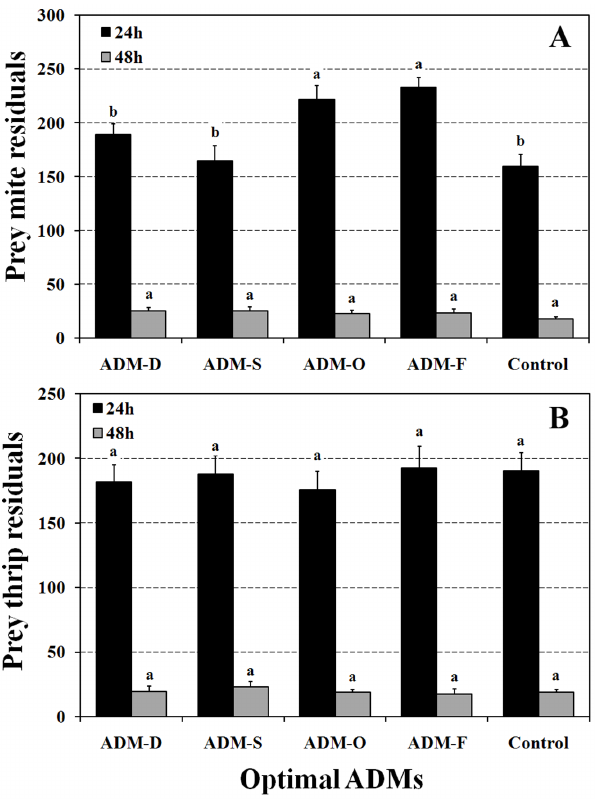
Figure 6. The number of prey leaf mites T.cinnabarinus (A) and F.occidentalis (B) left after 24 h and 48 h of predation by O. sauteri reared on either optimal ADMs or T.cinnabarinus . The columns and bars represent mean + SE. The different letters at the top of columns in the same color indicate significant differences based on the LSD test (P , 0.05).